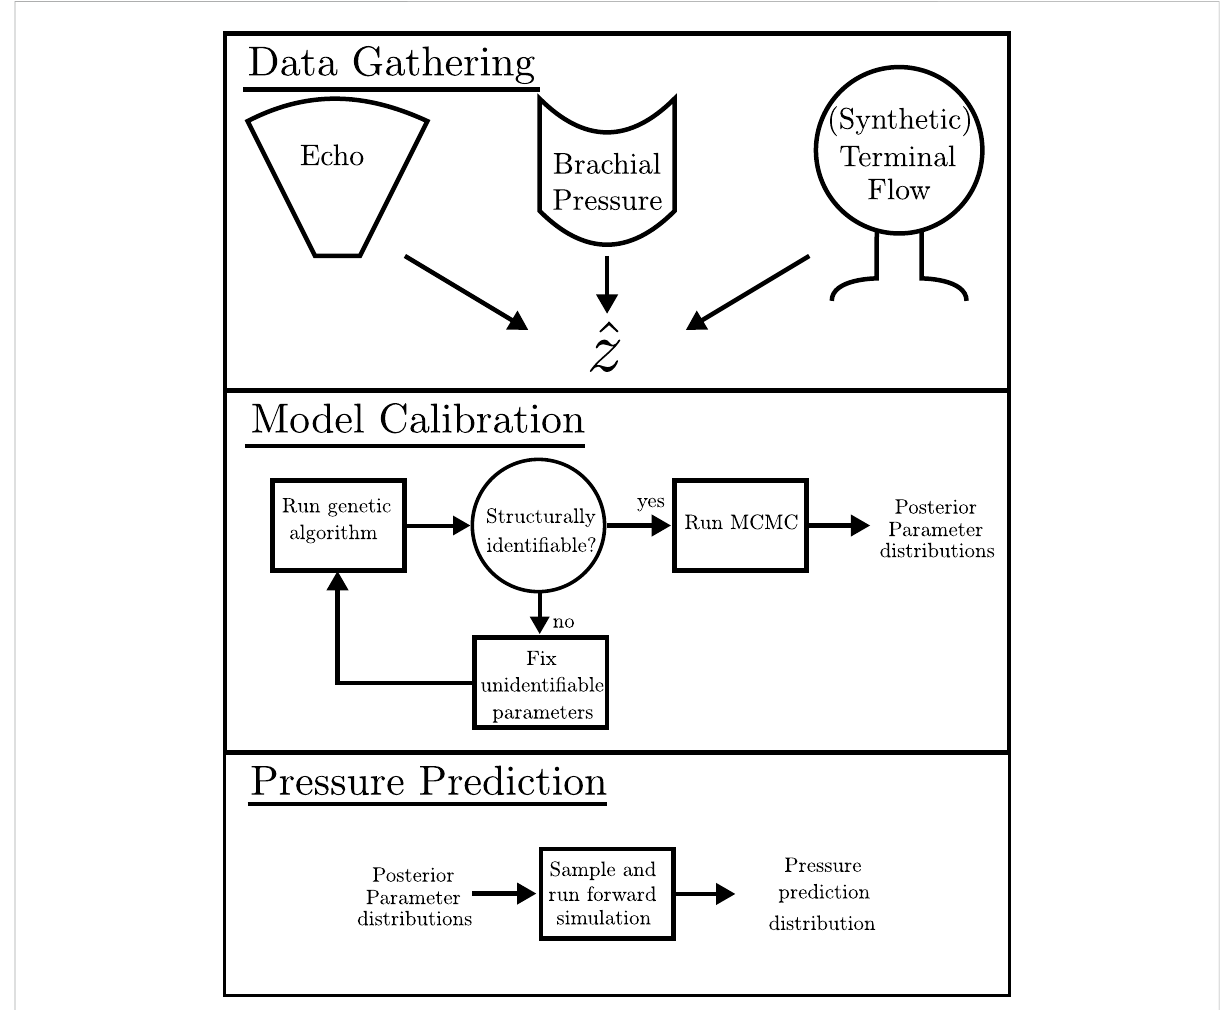
FIGURE 2 Schematic detailing the pipeline for required data, the calibration process, and the calculation of the pressure prediction distribution.